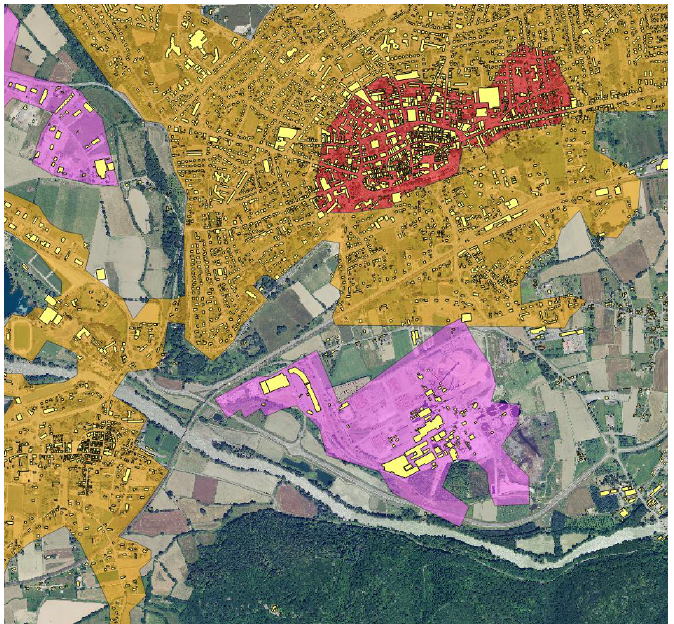
Figure 5. Before refinement of urban classes: individual buildings from BD-Topo in yellow, Continuous Urban Fabric (CUF) in red, Discontinuous Urban Fabric (DUF) in orange and Industrial and Commercial Units (ICU) in